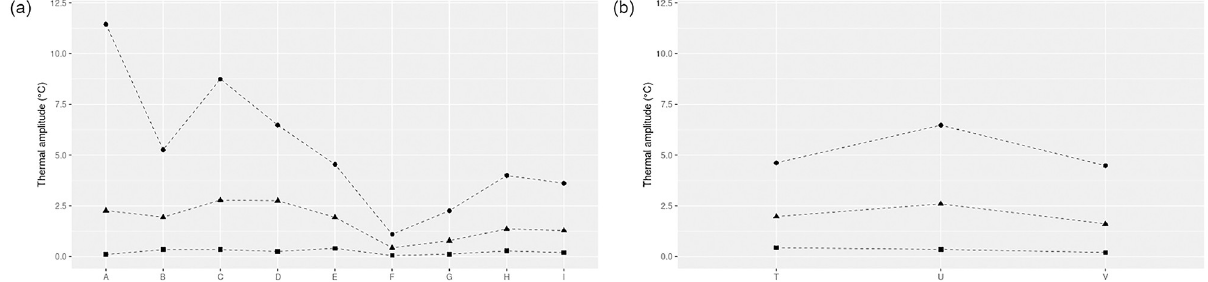
Fig 3. Thermal amplitude (daily maximum temperature—daily minimum temperature) along Soultzbach (a) and Trautbach (b) streams. Letters indicate monitoring stations. Red line: maximum thermal amplitude across the study period. Green line: minimum thermal amplitude across the study period. Blue line: mean thermal amplitude across the study